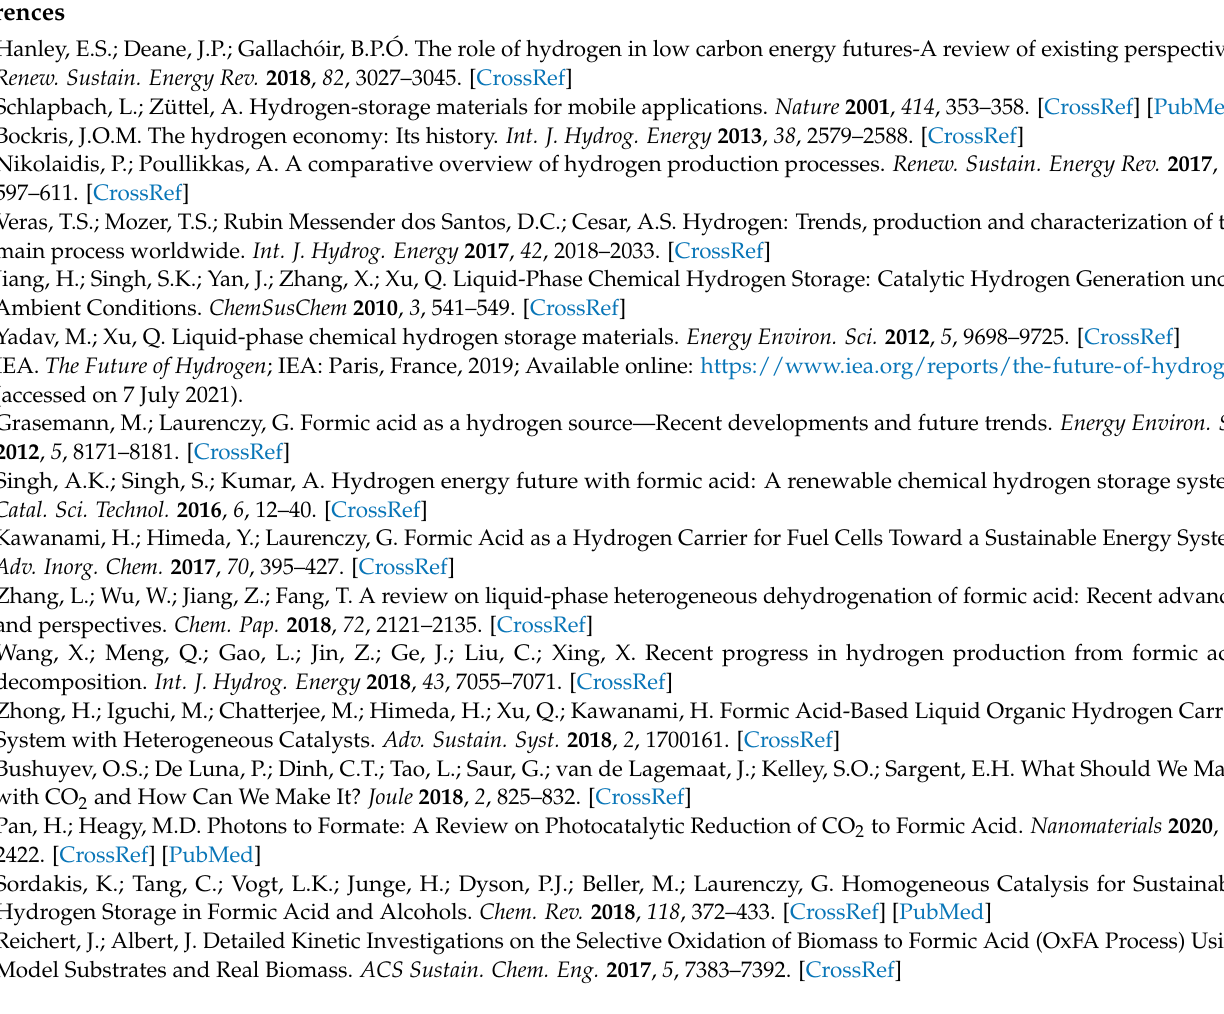
different composition title, Figure S2: Experimental proton EBS spectrum from the High Pd-C film supported on silicon, Figure S3: Arrhenius plots for the Pd-C coatings with different composition, Figure S4: Activity and selectivity as a function of temperature and particle size of a 0.5 wt.%